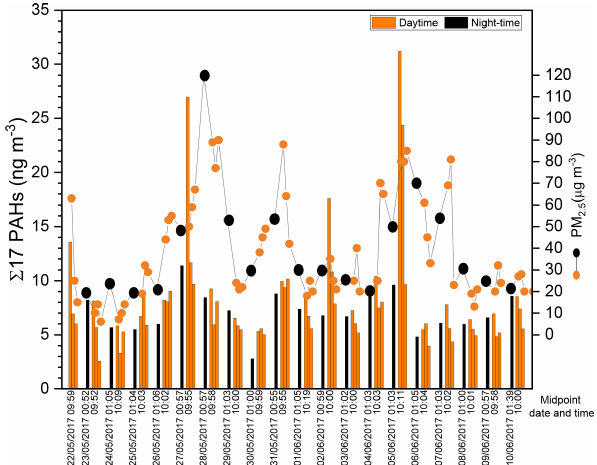
Figure 1. Temporal variation of total PAHs and PM 2 . 5 concentra- tions in summer Beijing. PM 2 . 5 concentrations were averaged to the filter sampling time, approximately 3h in daytime and 15h at night. The 3h midpoint time tick labels at noon ( ∼ 13:00) and in the afternoon ( ∼ 16:00) have been omitted for clarity.